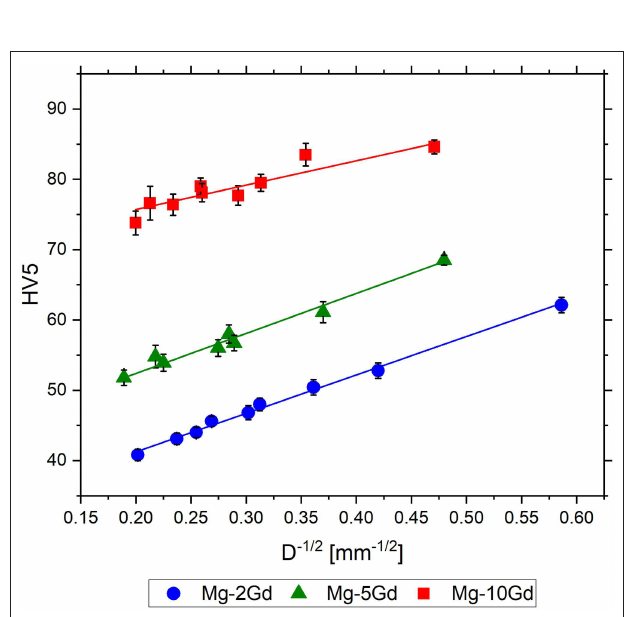
FIGURE 10 | Effect of grain size on hardness. Error bars are standard deviations.